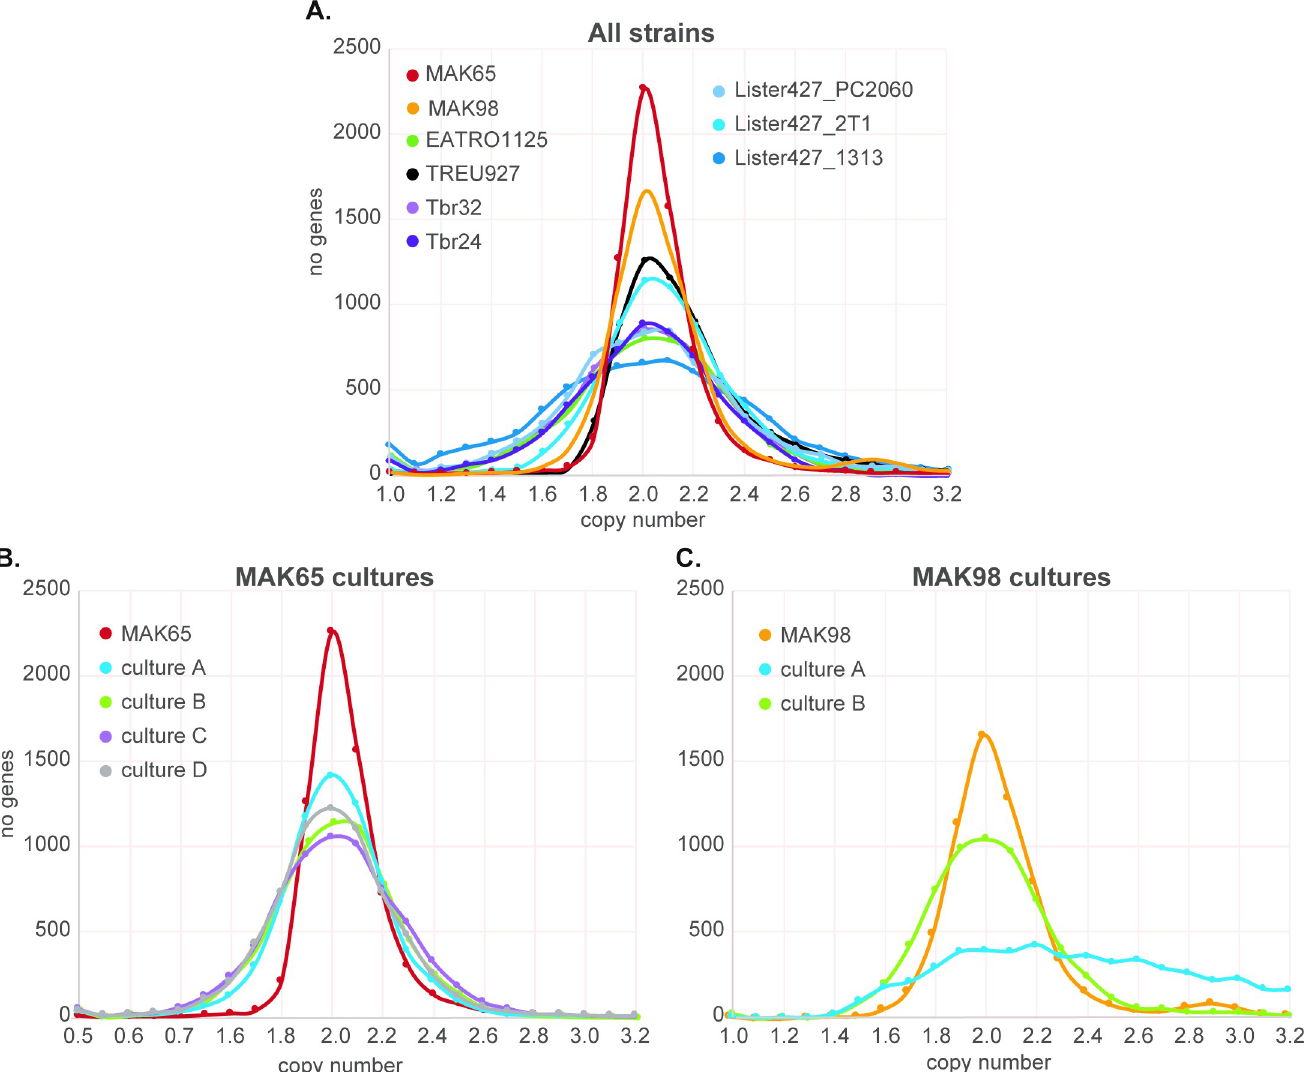
Fig 4. Copy number distributions for different trypanosome strains and cultures. After genome sequencing all reads were allowed to align 20 times. For a set of unique genes, containing one representative each for each set of repeated genes, reads per million reads were calculated. Copy numbers for each gene were then calculated based on the assumption that most genes are present once in every haploid genome (or twice per diploid genome). The numbers of genes with copy numbers between 1 and 4 are plotted here for the strains and cultures indicated. A. T . rhodesiense , TREU927, EATRO1125 and Lister 427. B. MAK65 from rats and culture C. MAK98 from rats and